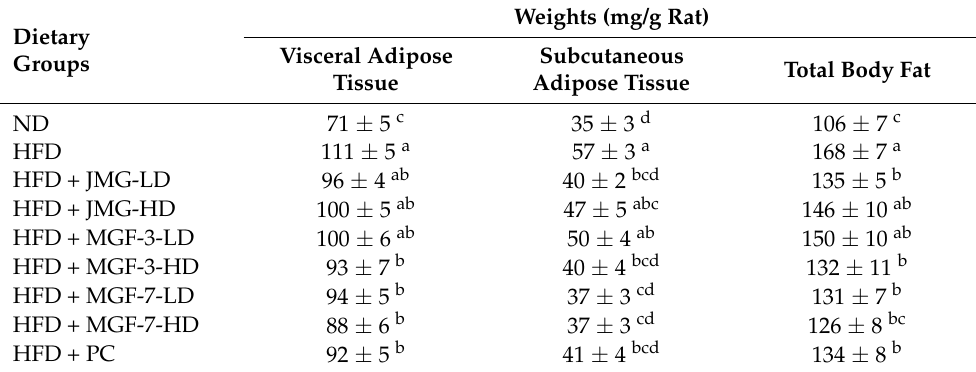
All values are presented as mean ± SEM. The values with different letters indicated a significant change between groups as determined by one-way ANOVA with post hoc Duncan’s test. Differences were considered statistically significant when p < 0.05. Table 5. Effects of Mei-Gin formulas on the weights of total body fat and adipose tissue in high-fat diet-induced obese